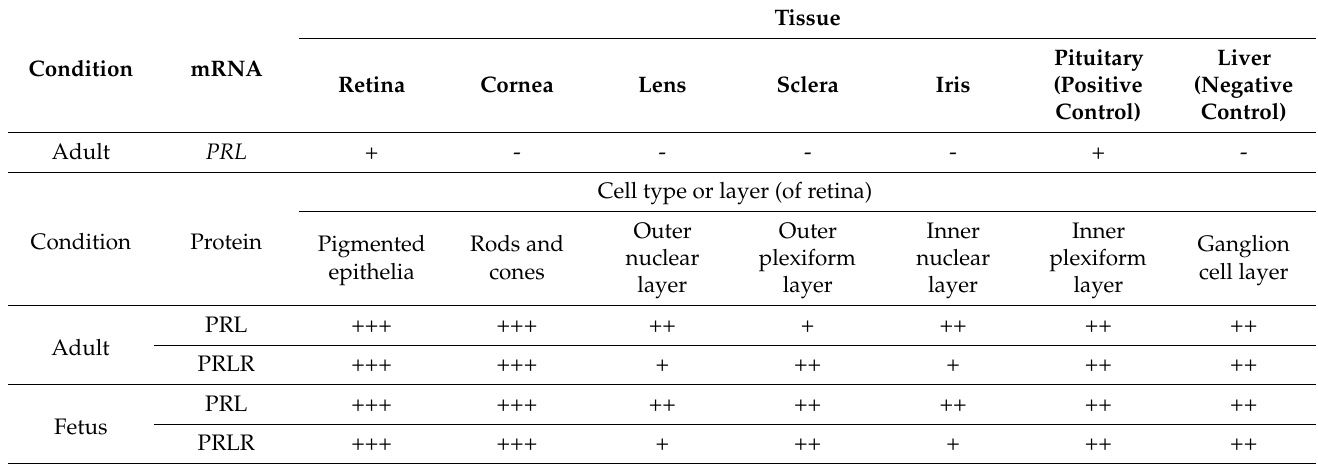
Table 1. Tissue distribution of PRL mRNAs and proteins in baboon